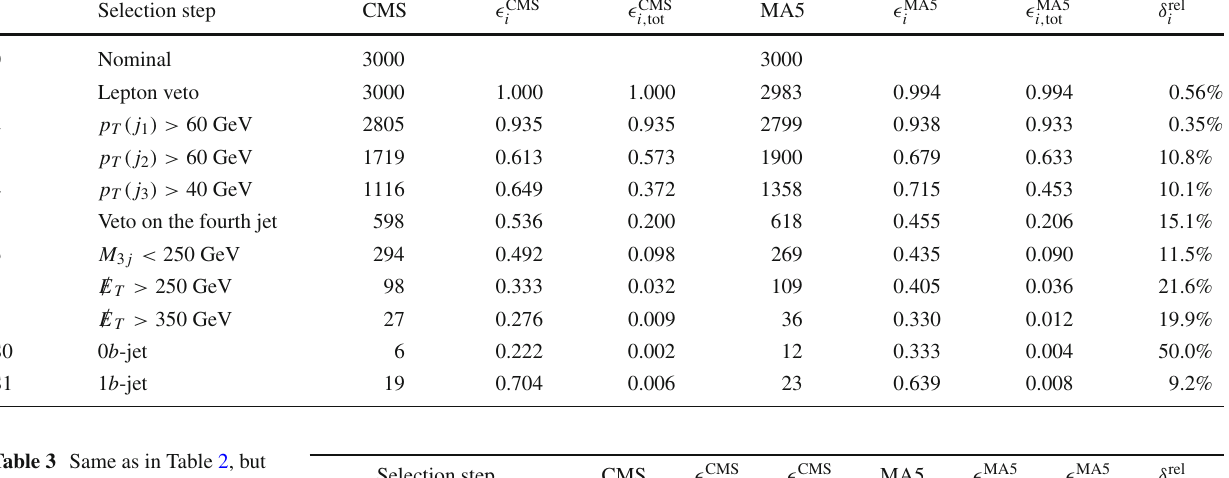
Table 3 Same as in Table 2, but for a new physics